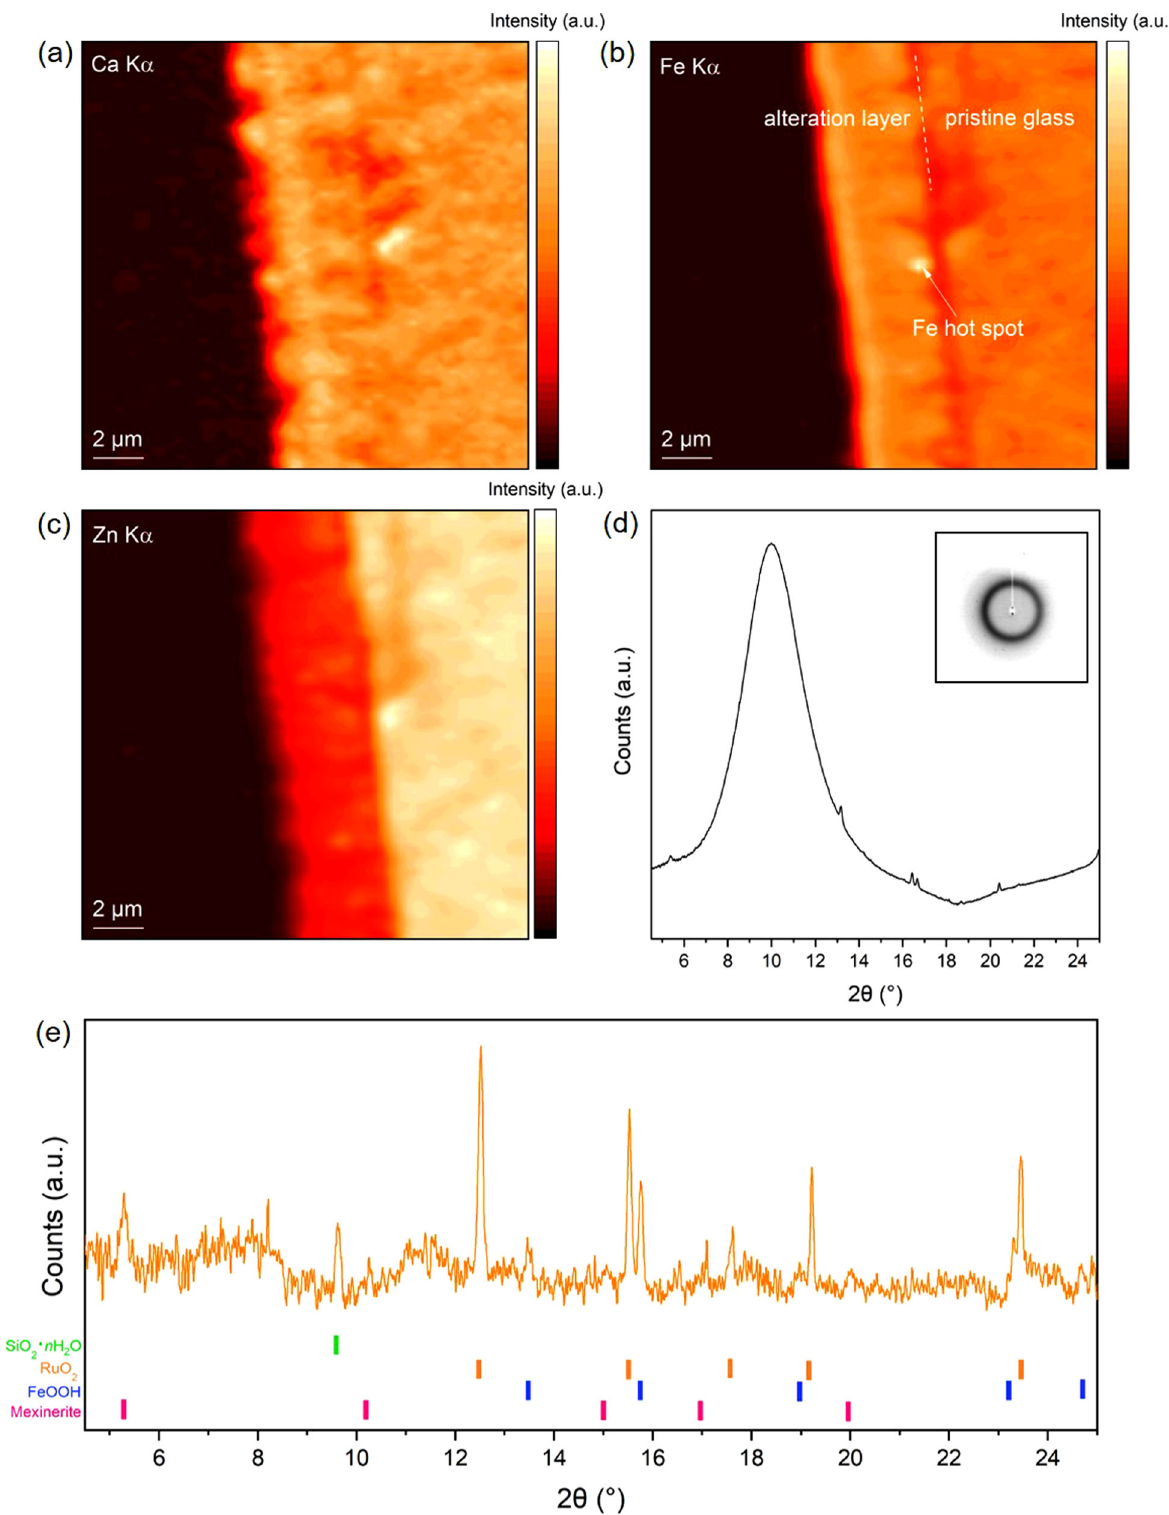
Fig. 4 Micro x-ray analysis of CaZn28 glass after 84 d of dissolution in Young Cement Water. Images showing the µ-XRF maps relating to the distribution of ( a ) Ca; ( b ) Fe; and ( c ) Zn. µ-XRD data are shown in ( d ) which depicts summed, un-calibrated, µ-XRD patterns with a 2D XRD pattern inset; and ( e ) showing the background subtracted, summed µ-XRD data. Phases were indexed as SiO 2 · n H 2 O (PDF #00-038-0448); FeOOH (PDF #01-074-3080), meixnerite (Mg 6 Al 2 (OH) 18 ·4H 2 O; PDF #00-035-0965) and RuO 2 (PDF